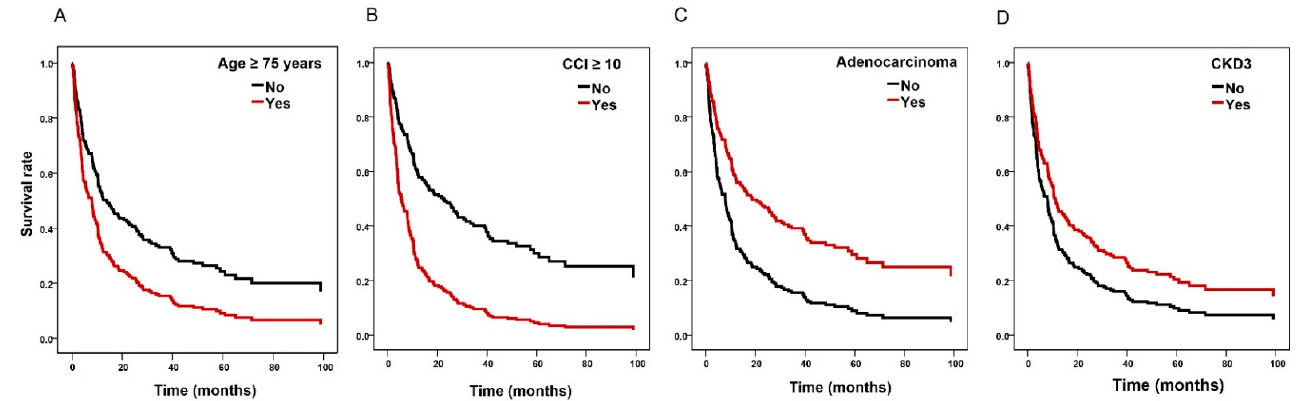
Figure 4. Cox’s proportional hazards regression model for overall survival of lung cancer patients with moderate chronic kidney disease stage (CKD). ( A ) old age ( ≥ 75 years), ( B ) Charlson comorbidities index ( ≥ 10), ( C ) pathologic type of adenocarcinoma, and ( D ) CKD stage 3.